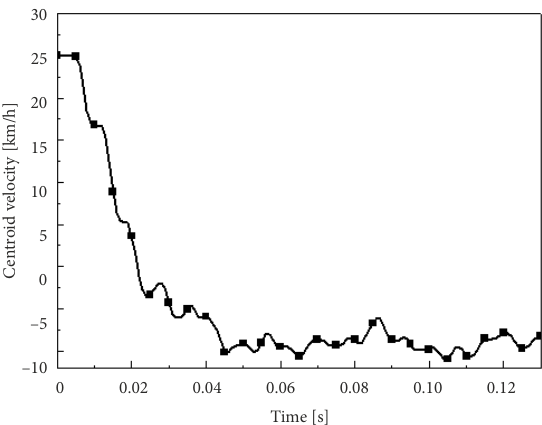
Figure 15. Speed change of the gravity center of the vehicle